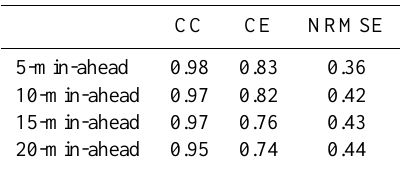
Table 3. Testing results of the water level prediction at an ungauged site.